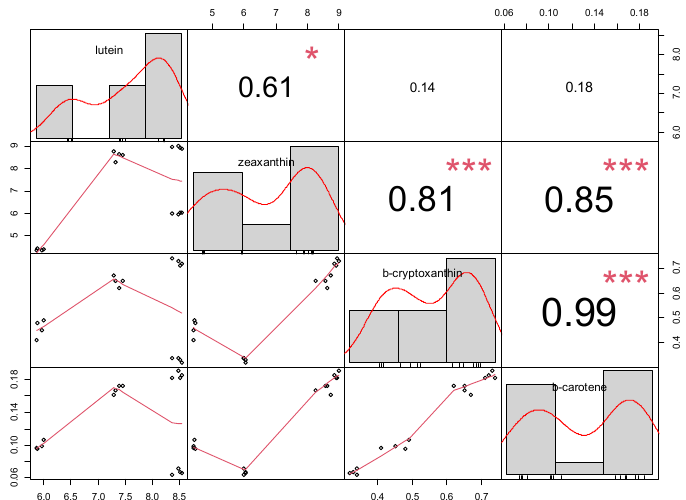
Figure 5. Correlation matrix of lutein, zeaxanthin, β -cryptoxanthin, β -carothene concentrations (mg kg − 1 dry matter). Note: *** ( p < 0.001), * ( p < 0.05).